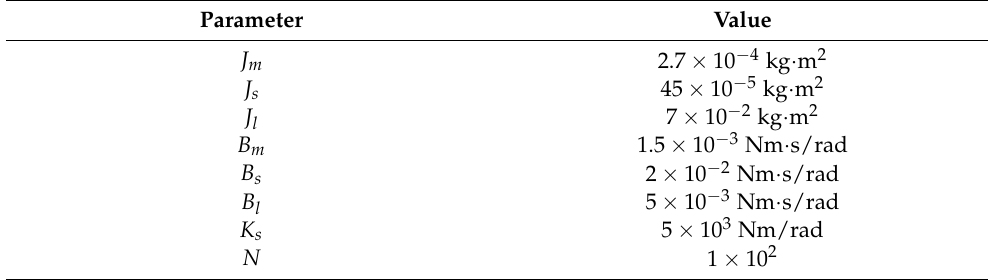
Table 2. The simulation parameters of the SEA